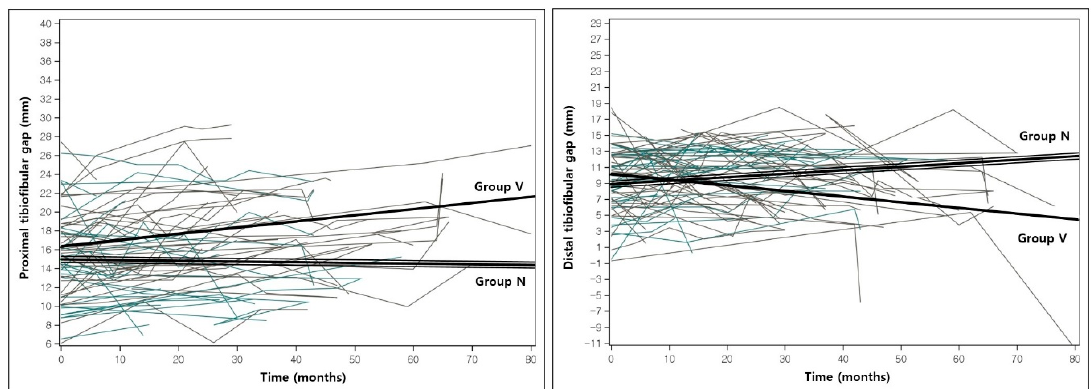
Figure 3. The spaghetti plot and estimated slopes in proximal and distal tibiofibular gaps of groups N and V. The solid line indicates the estimated slope of group V; and triple lines indicate the estimated slope of group N. Progressive fibular shortening with a significant increase in the proximal gap and a decrease in the distal tibiofibular gap were identified over time.